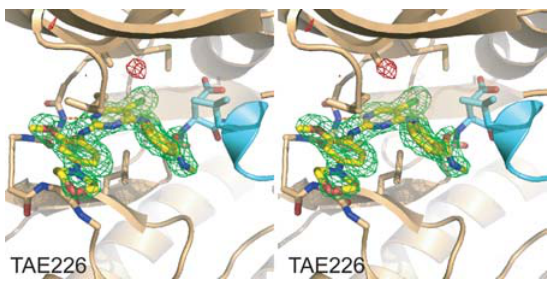
Figure 2. Difference electron density map for the FAK/TAE226 structure. Fo-Fc electron density calculated from experimental data and the final model with TAE226 removed is shown in stereo contoured at 3.5 s . Positive electron density is colored green and negative density is colored red. FAK is shown as beige ribbon with its activation loop in cyan. TAE226 (yellow) and sidechains involved in inhibitor binding are shown in stick representation. The ribbons of residues 429–431 in the P- loop are rendered transparent for clarity. Difference electron density for TAE226 is well defined. doi:10.1371/journal.pone.0003800.g002 PLoS ONE |